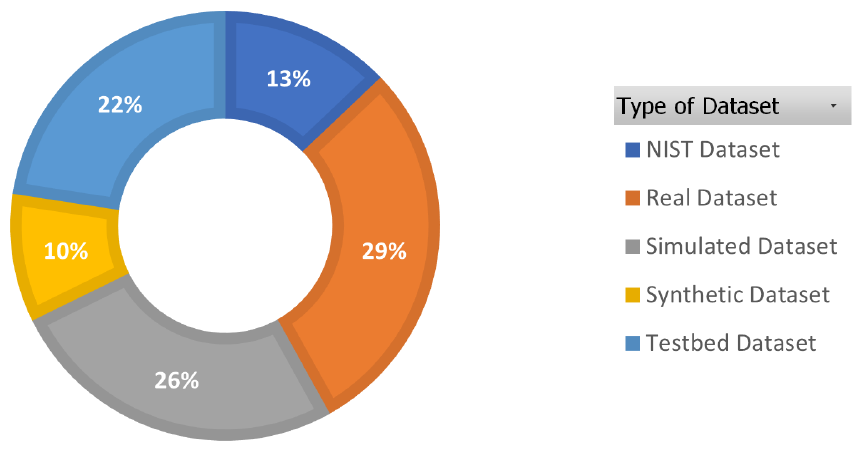
Figure 9. Dataset types used in selected